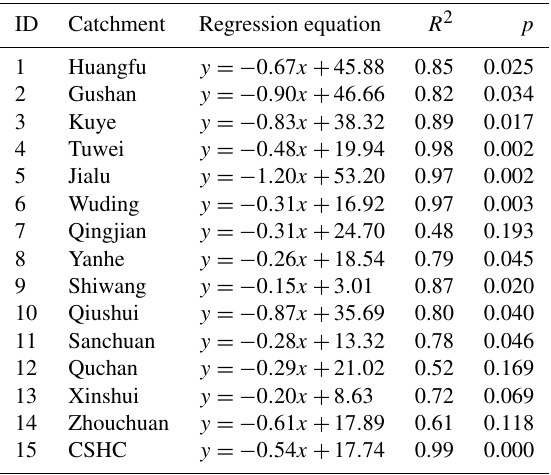
Table 5. Regression equations between the decadal sediment coef- ficient and percentage of the area affected by soil and water conser- vation measures (SC = − mA c + n) in the catchments.